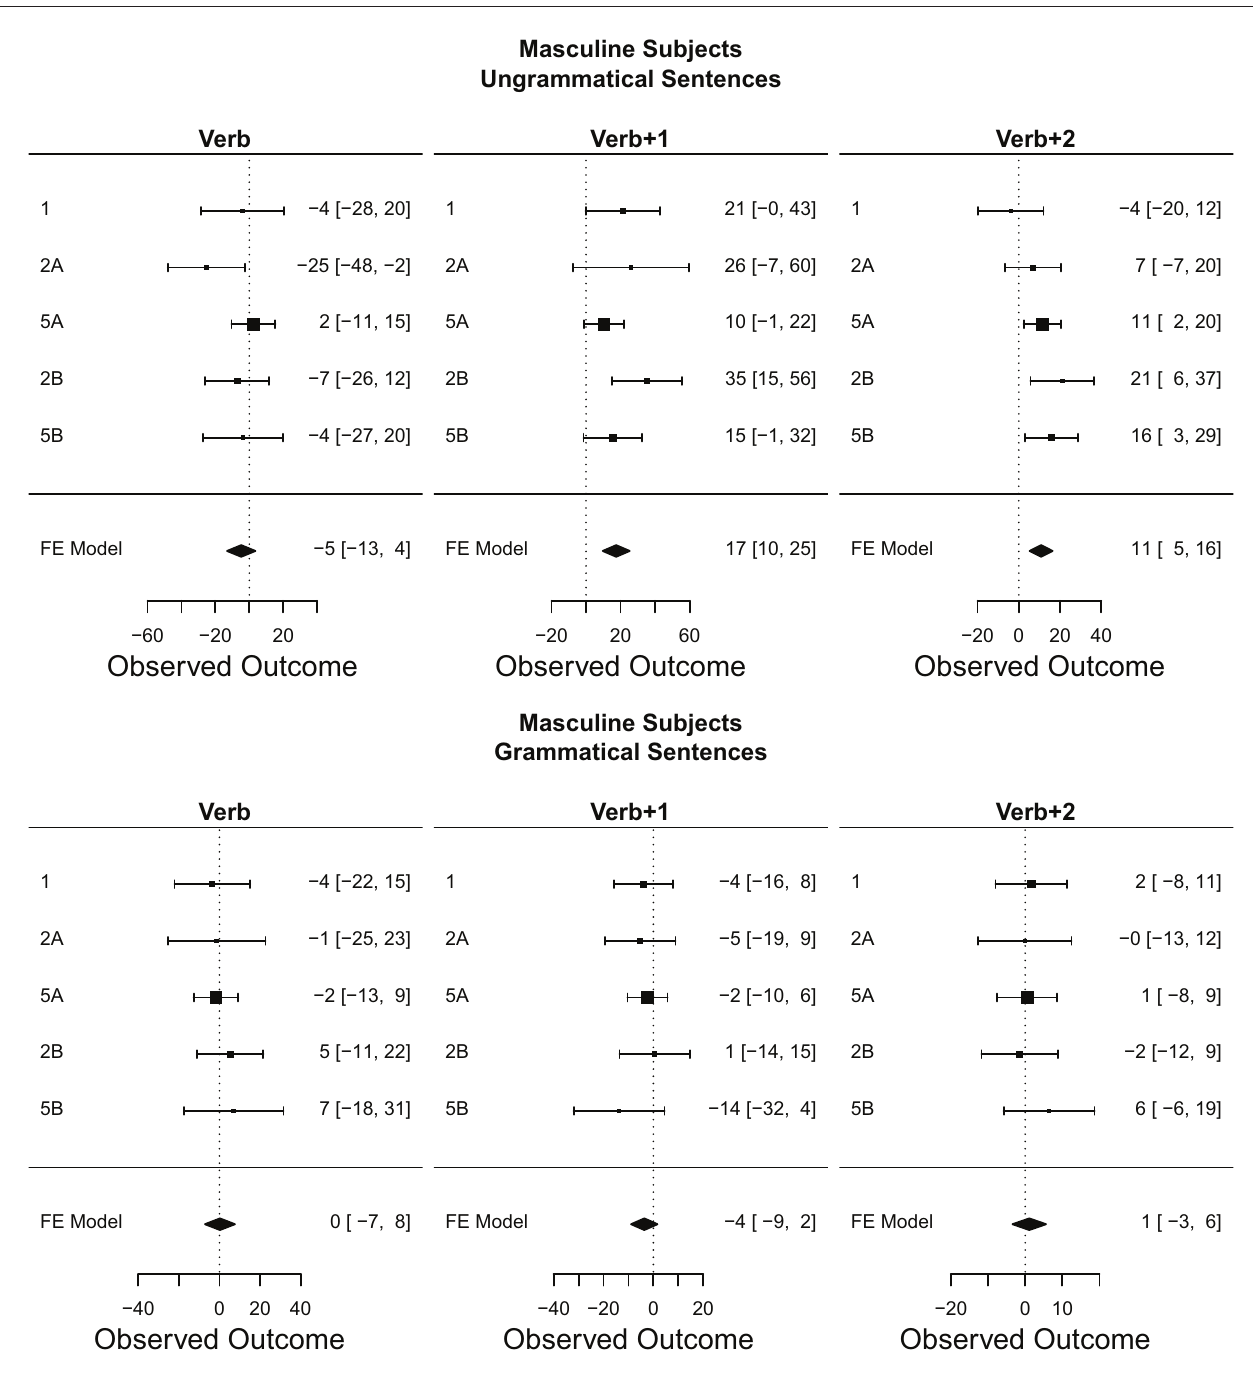
Figure 6 | Gender attraction effect in ungrammatical and grammatical sentences: forest plots of meta-analysis for masculine subjects. The size of the square representing each experiment is proportional to its weight in the meta-analysis. The estimated effect size of the meta-analysis is represented by the black diamond at the bottom of each graph. The width of the diamond represents the estimated 95% CI of the meta-analysis effect size. Experiments are plotted in chronological order from top to bottom.